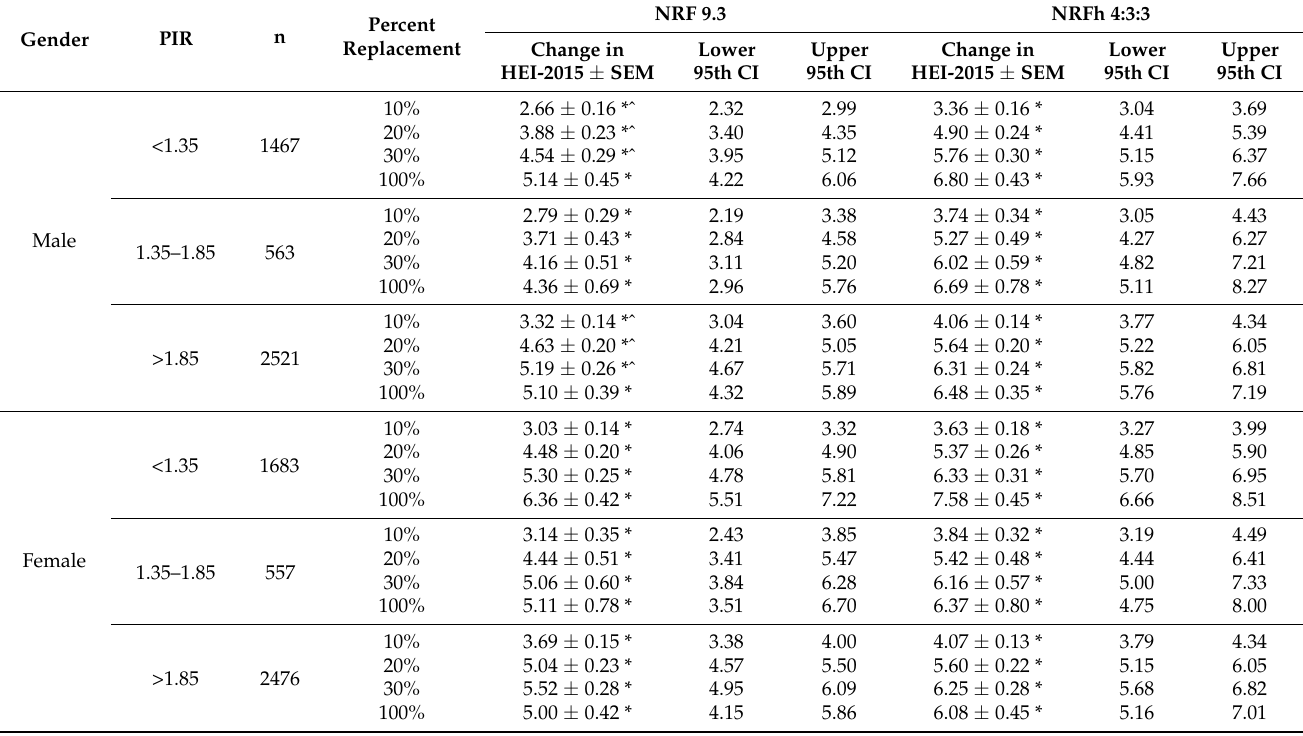
Table 6. Effect of replacing nutrient density T1 foods with T3 foods at 10%, 20%, 30%, and 100% level on HEI-2015 scores among adults (age > 19 years) by gender and PIR